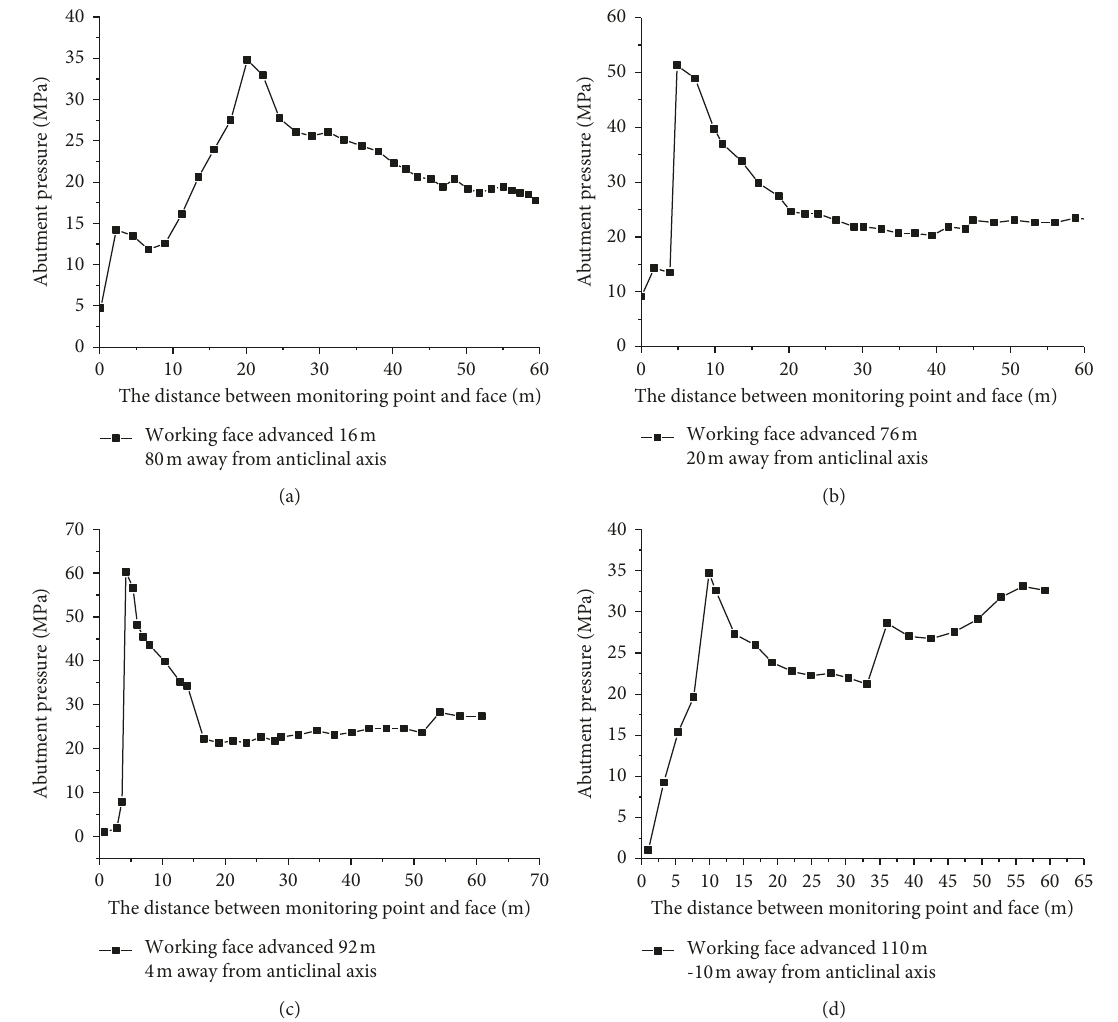
Figure 8: The distribution curves of abutment pressure in front of the coal wall with different advancing distances. (a), (b), (c), and